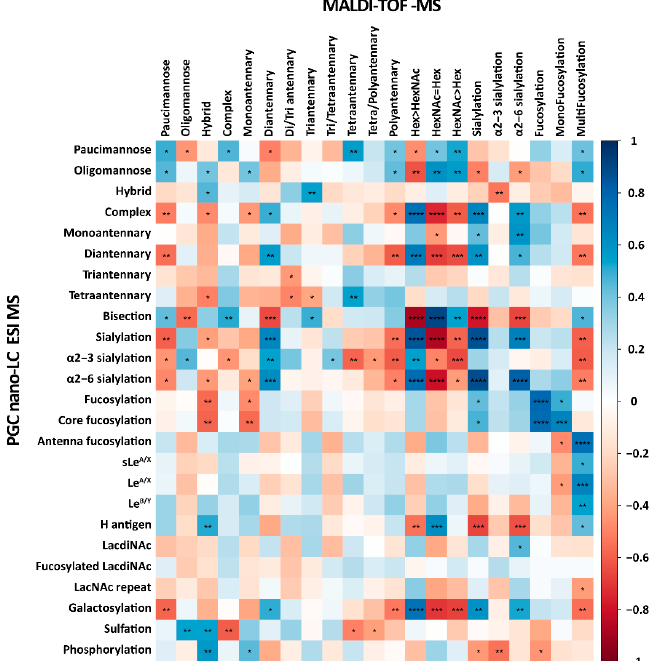
Figure 3. The correlation of N -glycan features in CRC cell lines measured by porous graphitized carbon nano-liquid chromatography electrospray ionization tandem mass spectrometry (PGC- nano-LC-ESI-MS) and matrix-assisted laser desorption/ionization time of flight-mass spectrometry (MALDI-TOF-MS). The Spearman correlation analysis was performed for the association of glyco- sylation features of N -glycans observed for the same set of CRC cell lines measured by PGC-nano- LC-ESI-MS in the present study and measured by MALDI-TOF-MS in the previous study [16]. Sig- nificant values are marked with * ( p ≤ 0.05), ** ( p ≤ 0.01), *** ( p ≤ 0.001) and **** ( p ≤ 0.0001). The color bar for correlation coefficient is displayed on the